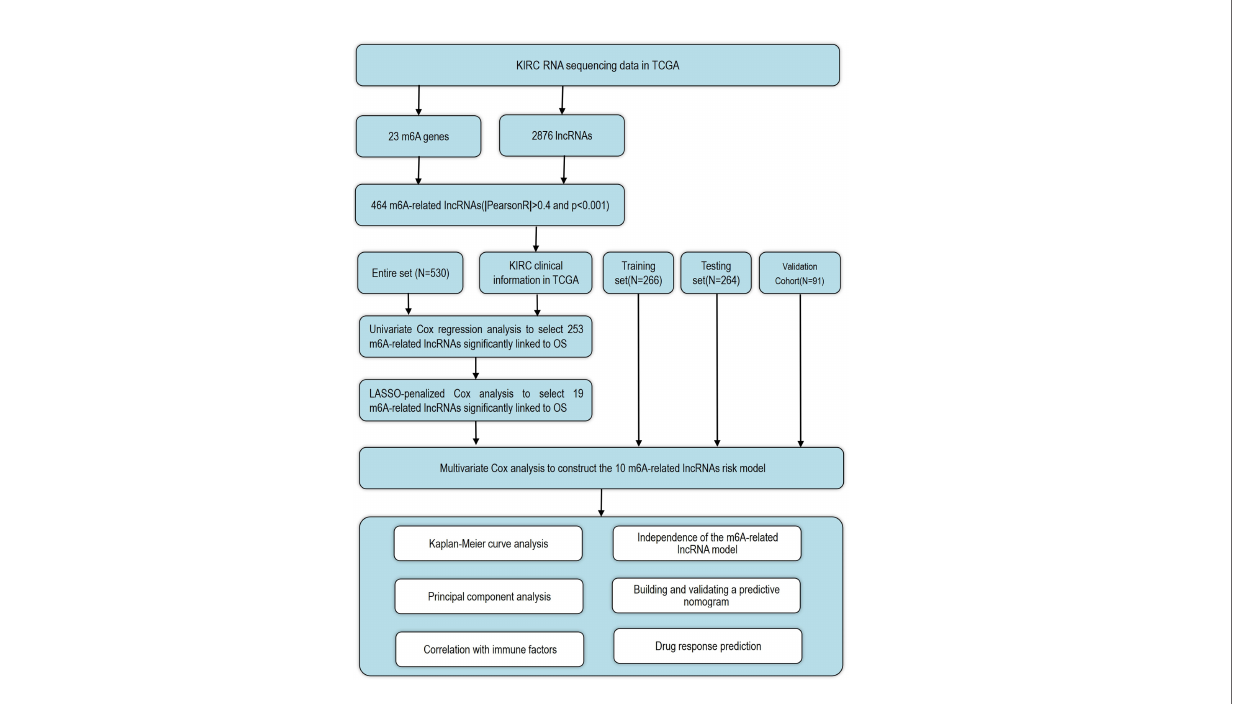
FIGURE 1 | The work fl ow of the